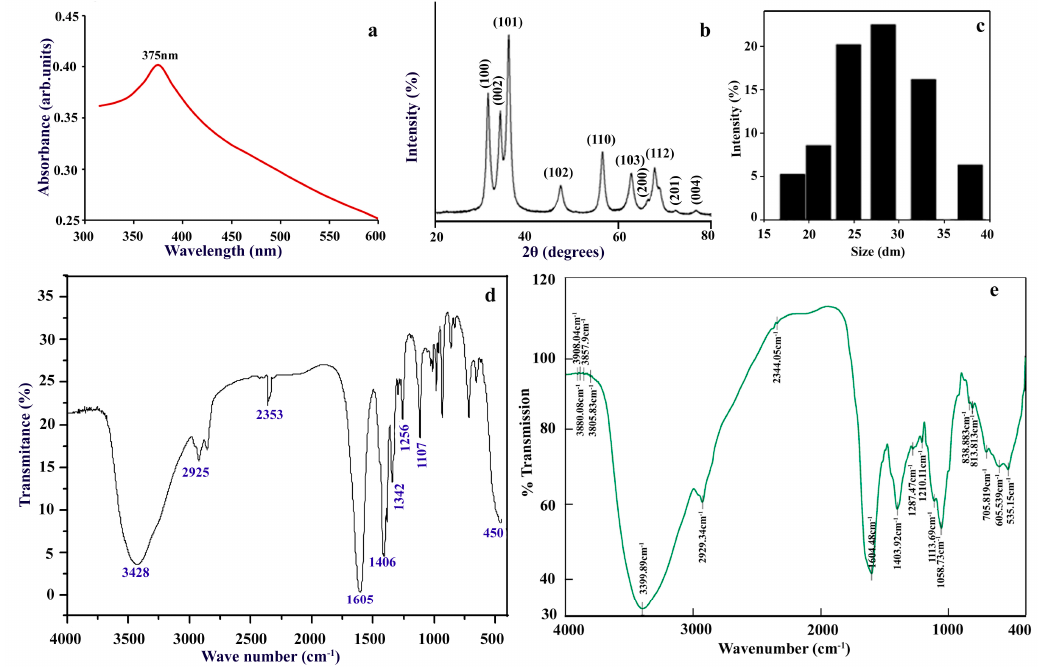
Figure 2. Characterization of green synthesized ZnO nanoparticles using C. verrucosa leaf. ( a ) UV-visible spectroscopy, ( b ) XRD, ( c ) Histogram showing DLS pattern of size distribution of ZnO-NPs, FTIR spectrum of ( d ) ZnO NPs and ( e ) leaf extract of Crotalaria verrucosa.